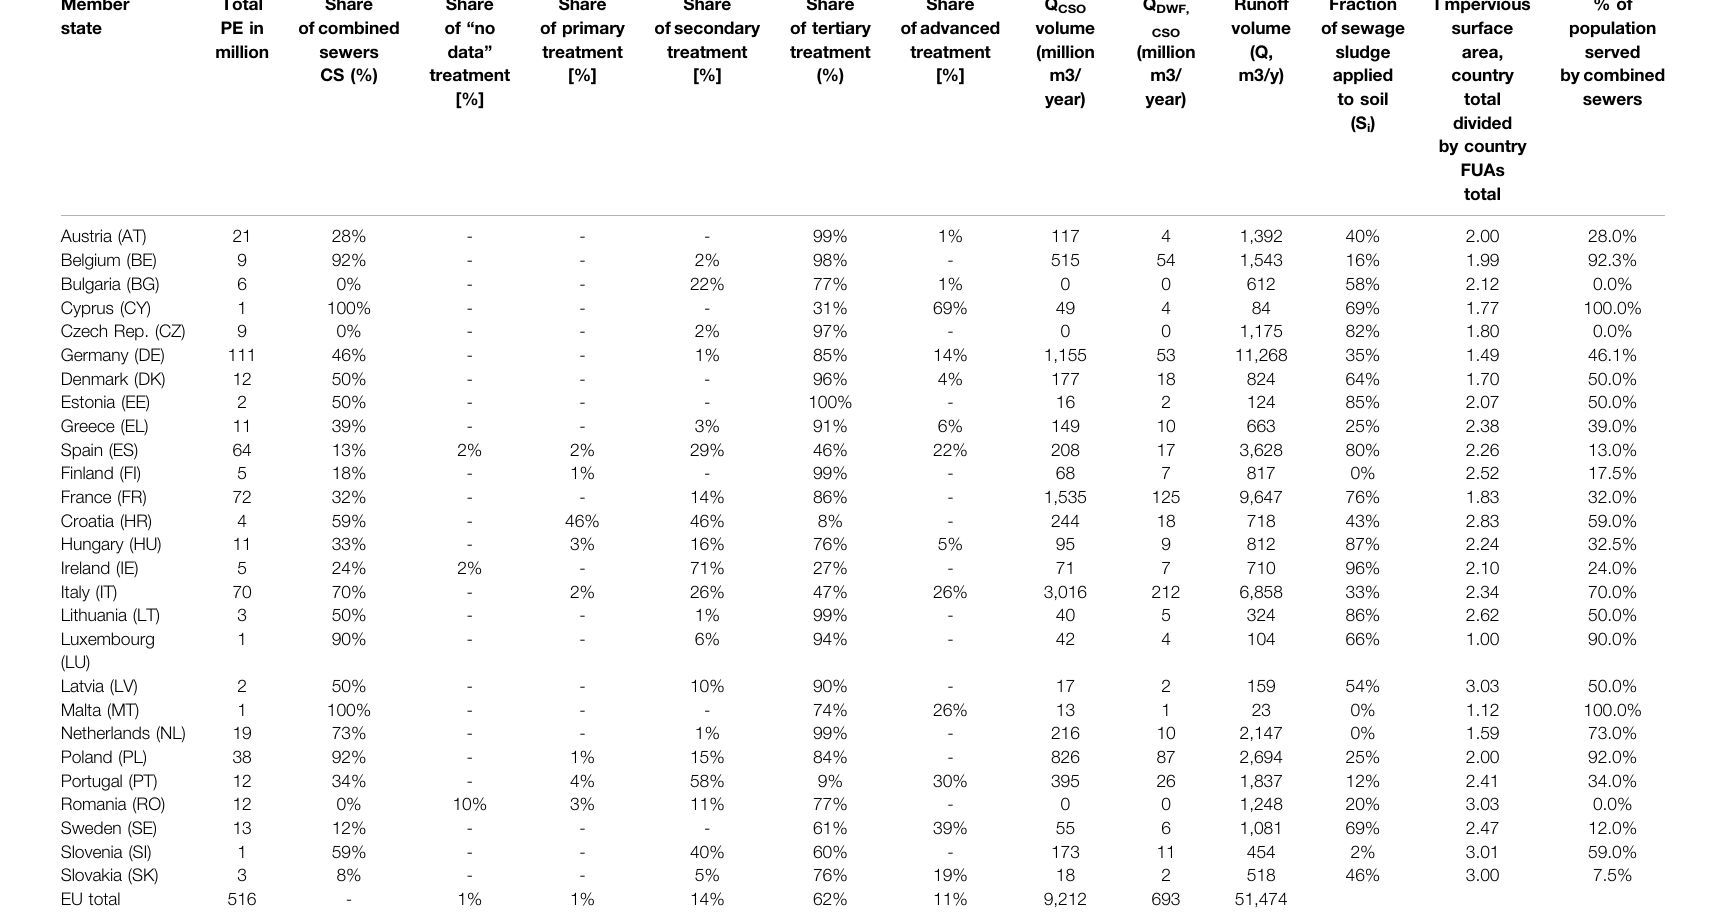
TABLE 2 | Descriptors of the wastewater and sewage sludge volume. Data sources: see main text. Member